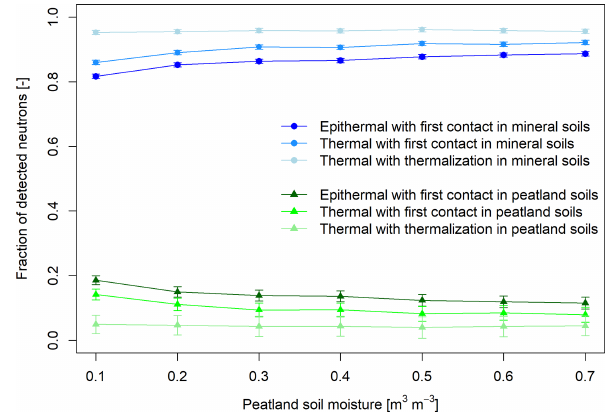
Figure 3. Simulation results for the measurement footprint ra- dius (a) and depth (b) of detected thermal and epithermal neutrons.